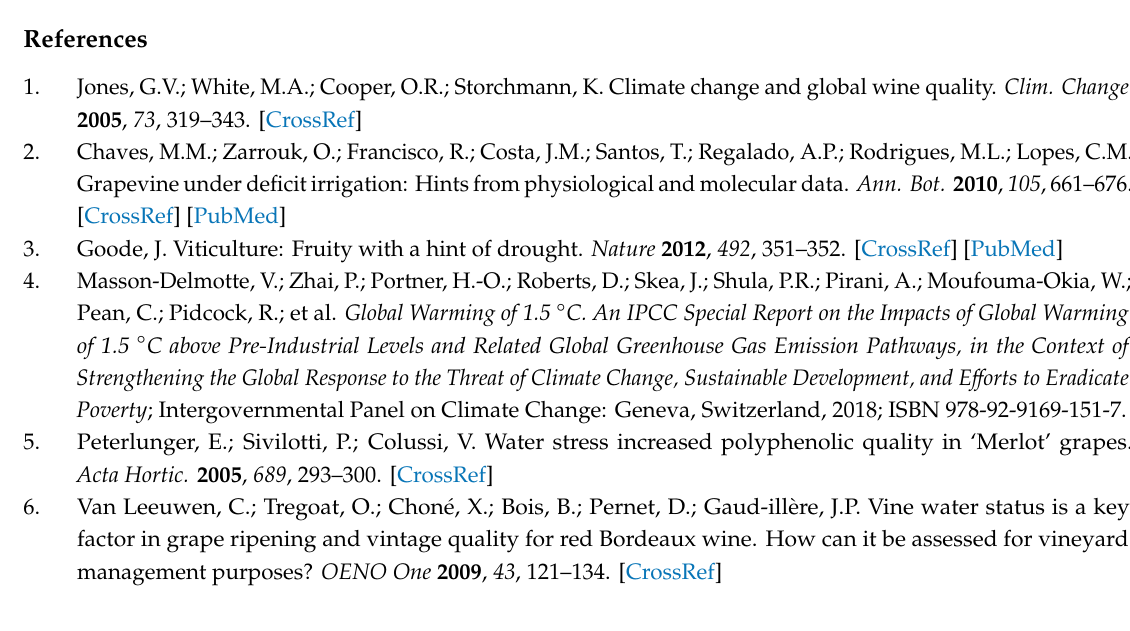
Table S1: List of forward, reverse and stem-loop reverse transcriptase primers used for qRT-PCR to test genes and miRNAs expression; Table S2: Midday stem water potentials ( Ψ stem ); Table S3: Leaf gas exchange: stomatal conductance ( gs ); Table S4: Leaf gas exchange: net assimilation (A); Table S5: Leaf gas exchange: leaf transpiration (E); Table S6: Chlorophyll fluorescence (Fv /